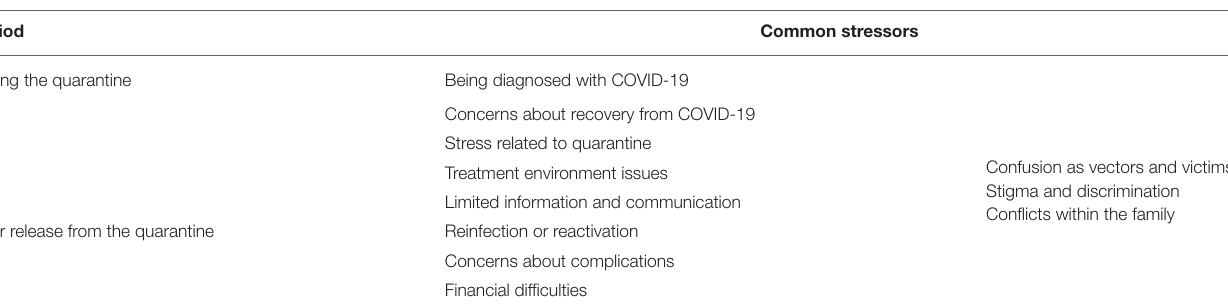
TABLE 2 | COVID-19 related stress divided by